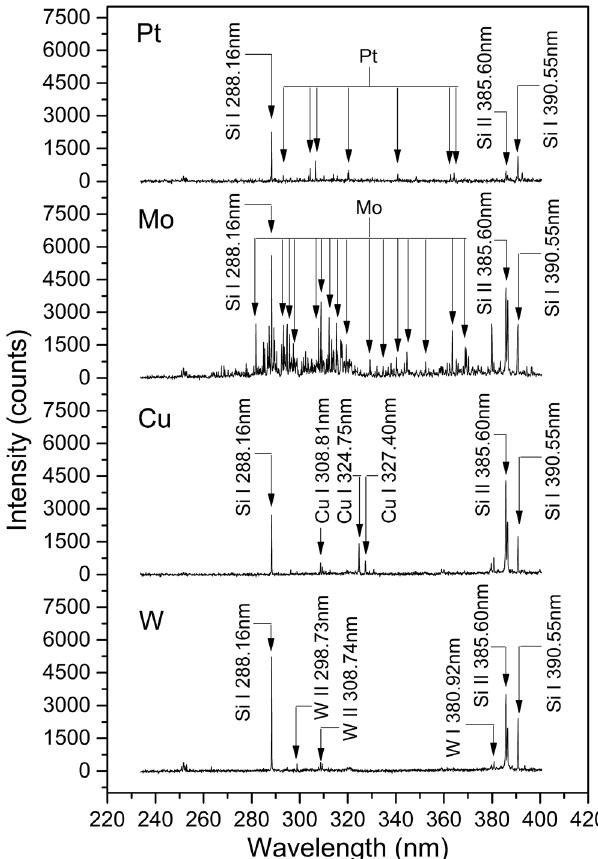
Figure 2. Spectra of quartz sands with different electrode materials.